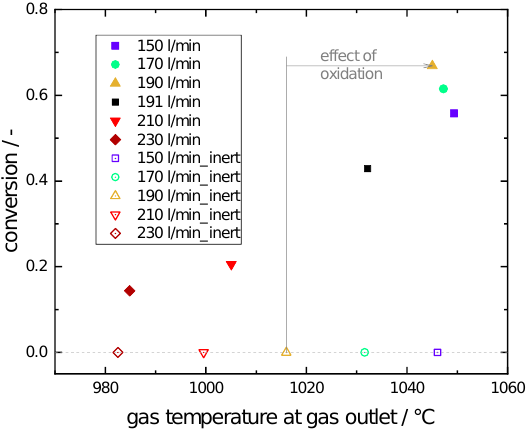
Figure 6. ( a ) Temperature profile of solid particles along the bed height of a moving bed (4g/s particle flow rate) with different gas flow rates operated in steady state. ( b ) Conversion profiles along the bed height of the moving bed reactor operated in steady state.